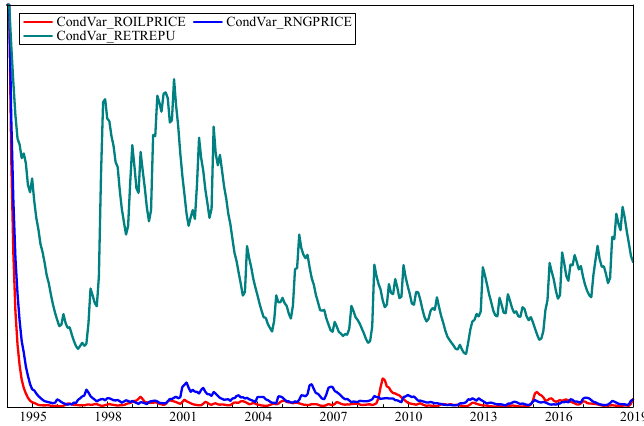
Figure 4. Conditional volatilities of Russian economic policy uncertainty and energy prices.